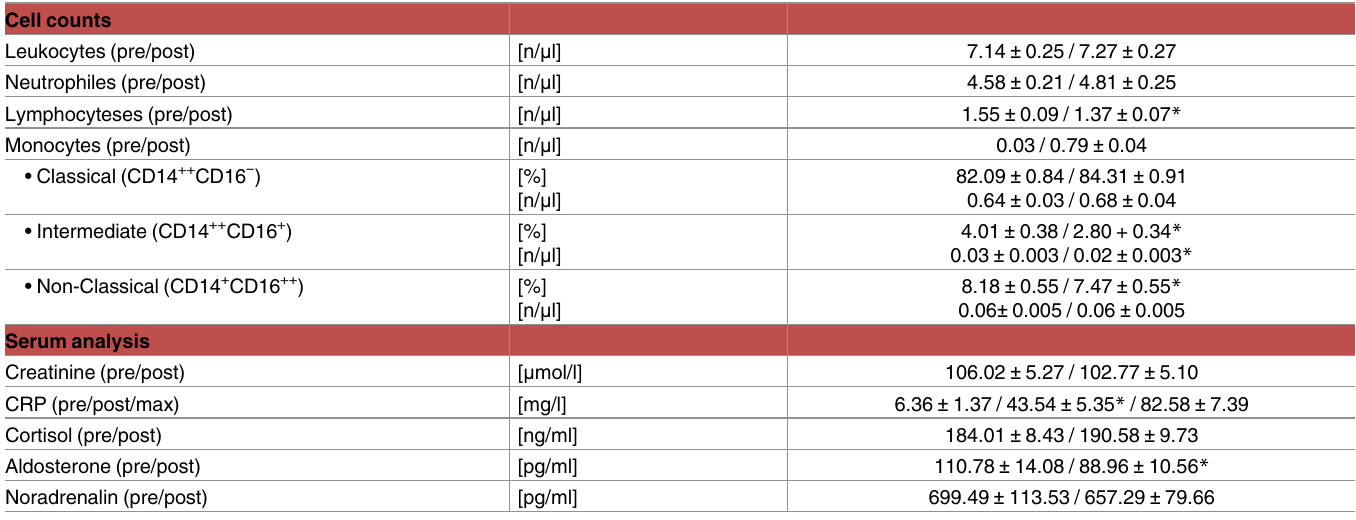
Table 2. Blood count and selected other laboratory values.